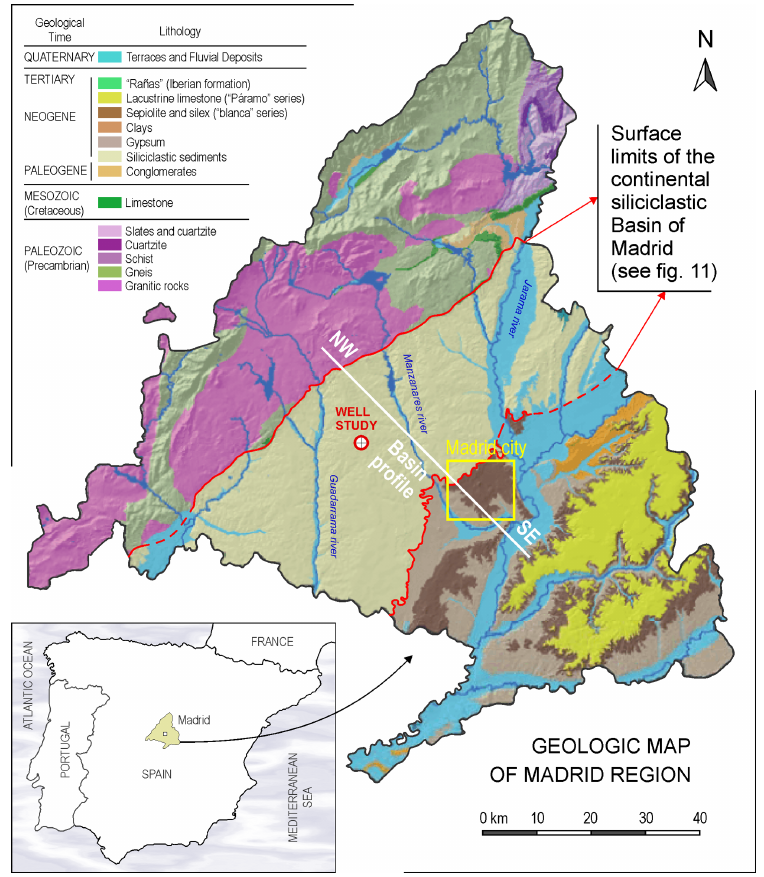
Figure 4. Geological map of the Madrid region (adapted from Diagnóstico Ambiental de la Comunidad de Madrid, 2020) with the studied well location and location of the schematic cross sections shown in Fig. 11.